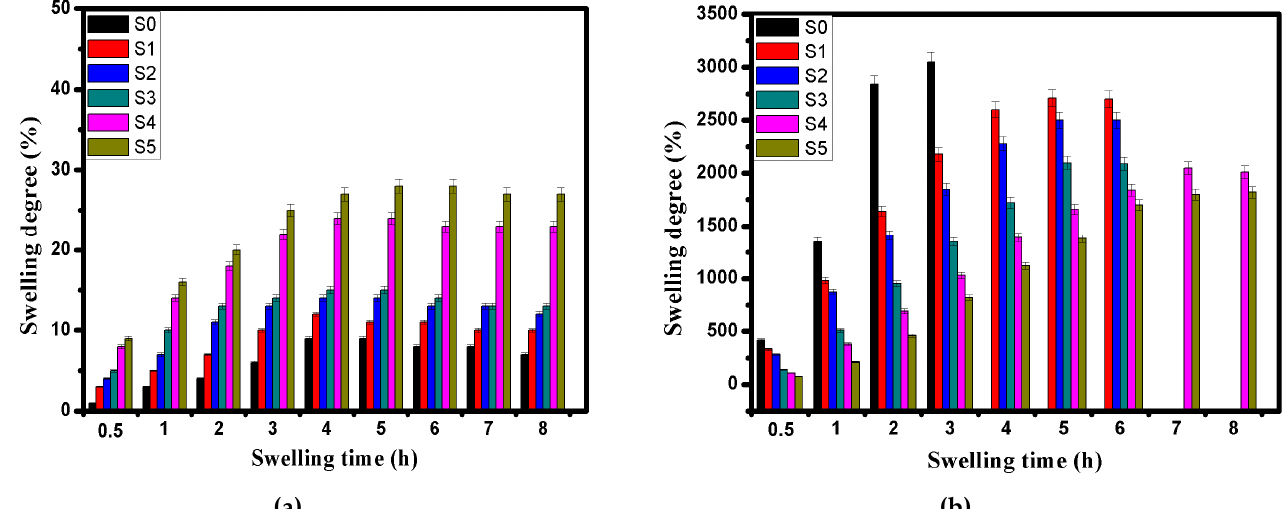
Figure 4. Swelling profiles for Alg (S0), Alg-CMCs single PEC (S1, S2, S3) and Alg-CMCs@AmCs dual PECs (S4, S5) microcapsules at ( a ) pH1.2 and ( b ) pH 7.4. Values were presented as means ± S.D ( n = 3), and significant data were determined at p -value ≤ 0.05 .